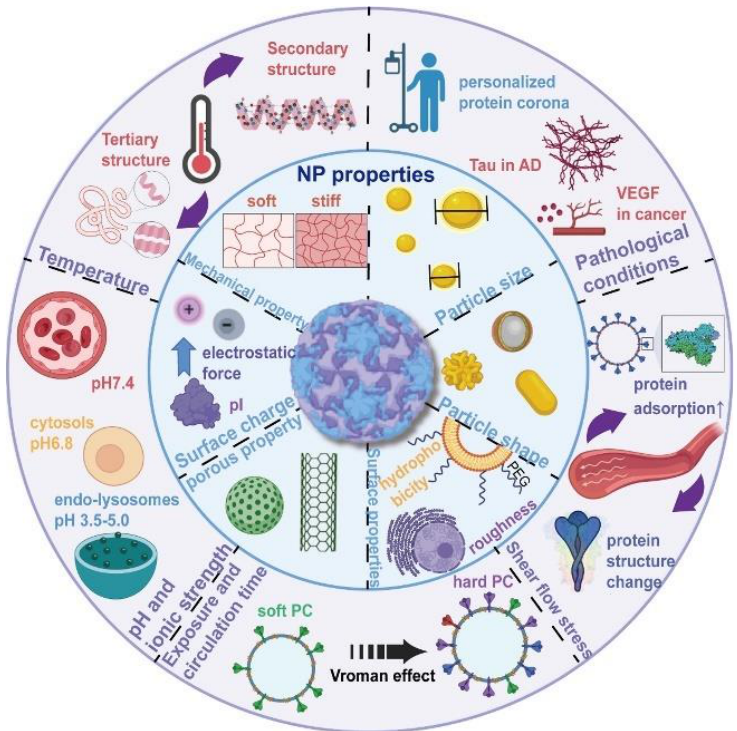
Figure 1. The major factors that influence the formation of protein corona can be divided into two categorized properties: NPs properties and biological environment properties. NPs properties mainly consist of particle size, shape, surface properties, porous properties, surface charge, and mechanical properties. Biological environment properties mainly consist of temperature, pH and ionic strength, exposure and circulation time, shear flow stress, and pathological conditions [19]. Copyright 2022, Elsevier.